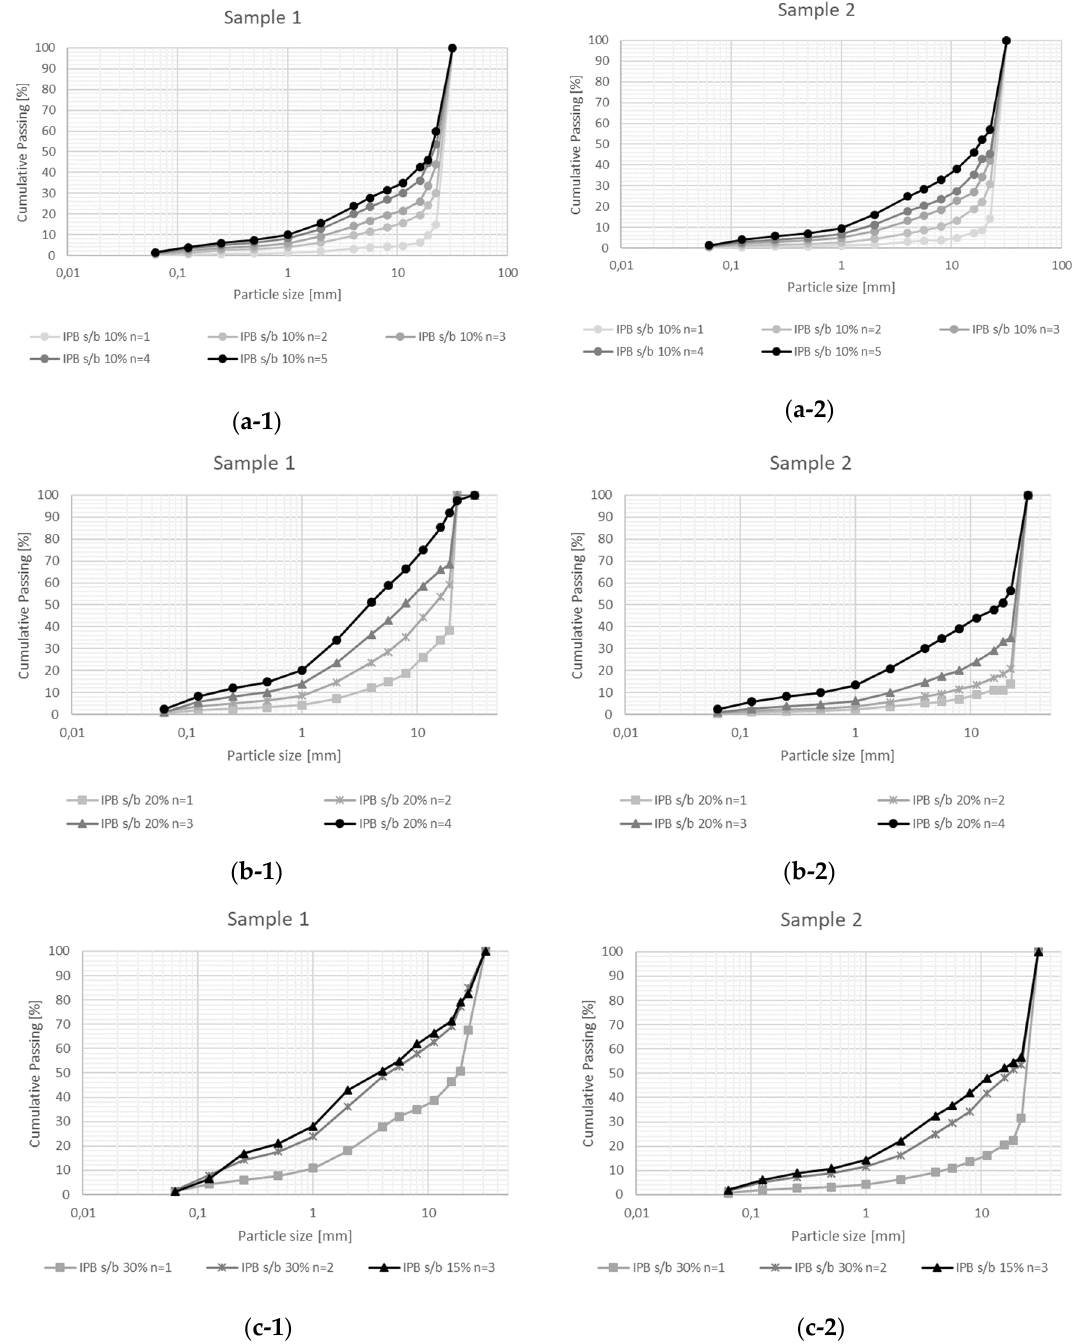
Figure 4. Product particle size cumulative distributions for Penouta ore sample 1 and sample 2 for ( a ) IPB s/b 10% test series (n = 1 to n = 5), ( b ) IPB s/b 20% test series (n = 1 to n = 4), and ( c ) IPB s/b 30% test series (n = 1 to n = 3). Where s/b is the compression ratio and n is the number of cycles.